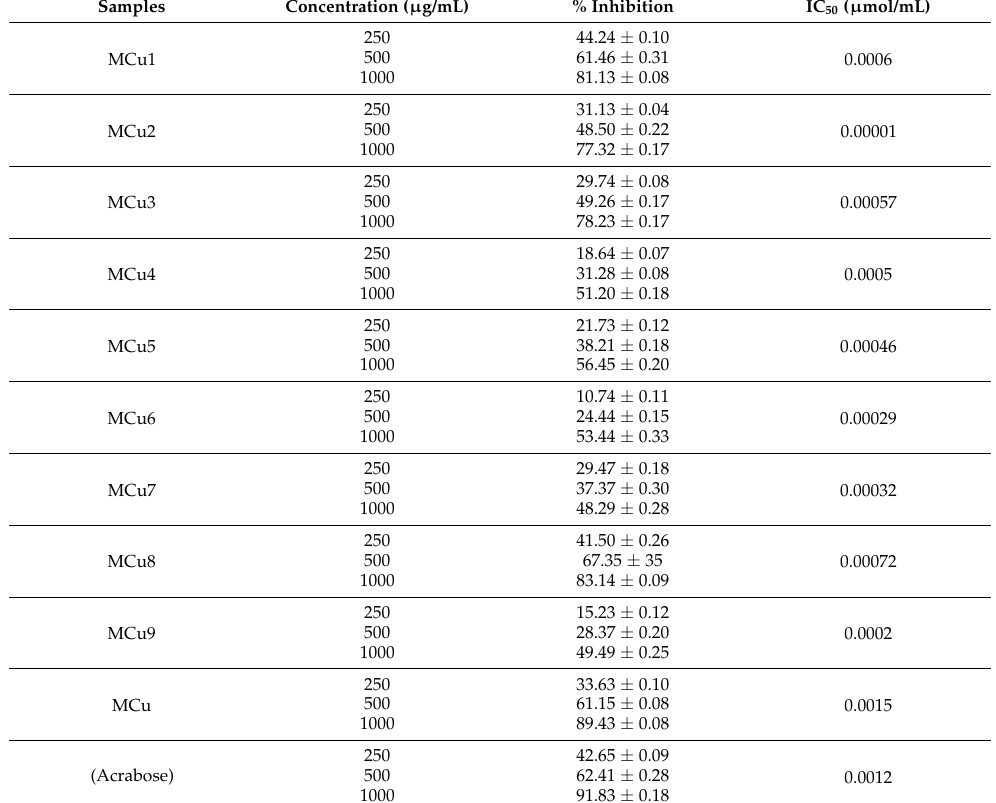
Table 5. α -Glucosidase activity of MCu1–MCu9.